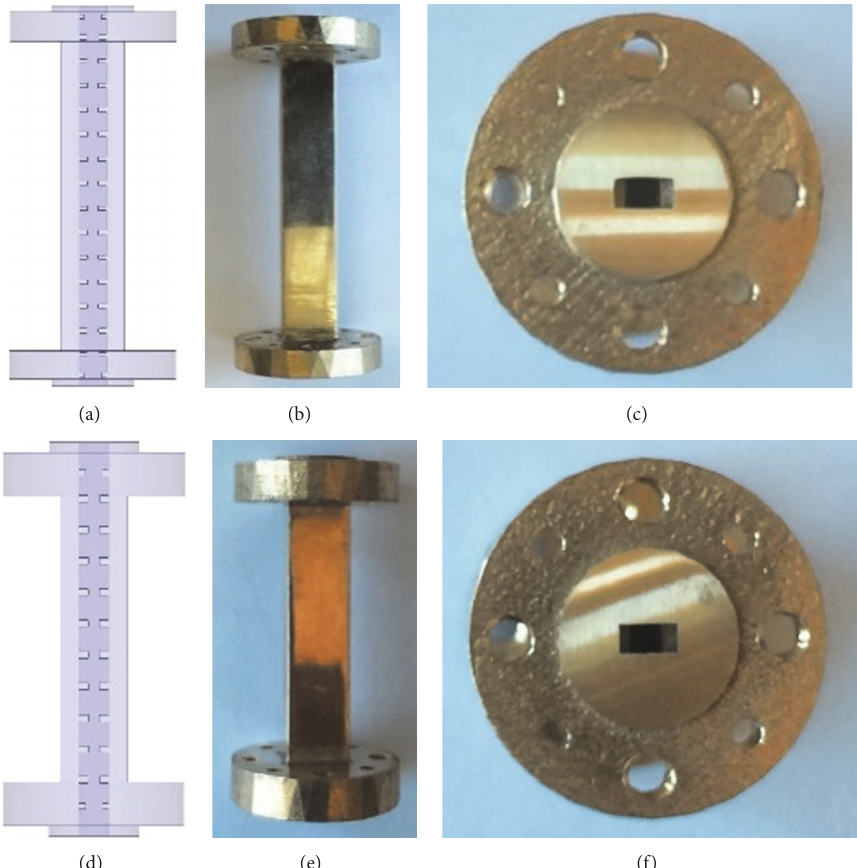
Figure 5: 3D printed BPFs: (a) 71–76 GHz BPF perspective view, (b) photograph, and (c) flange view; (d) 81–86 GHz BPF perspective view, (e) photograph, and (f) flange view.